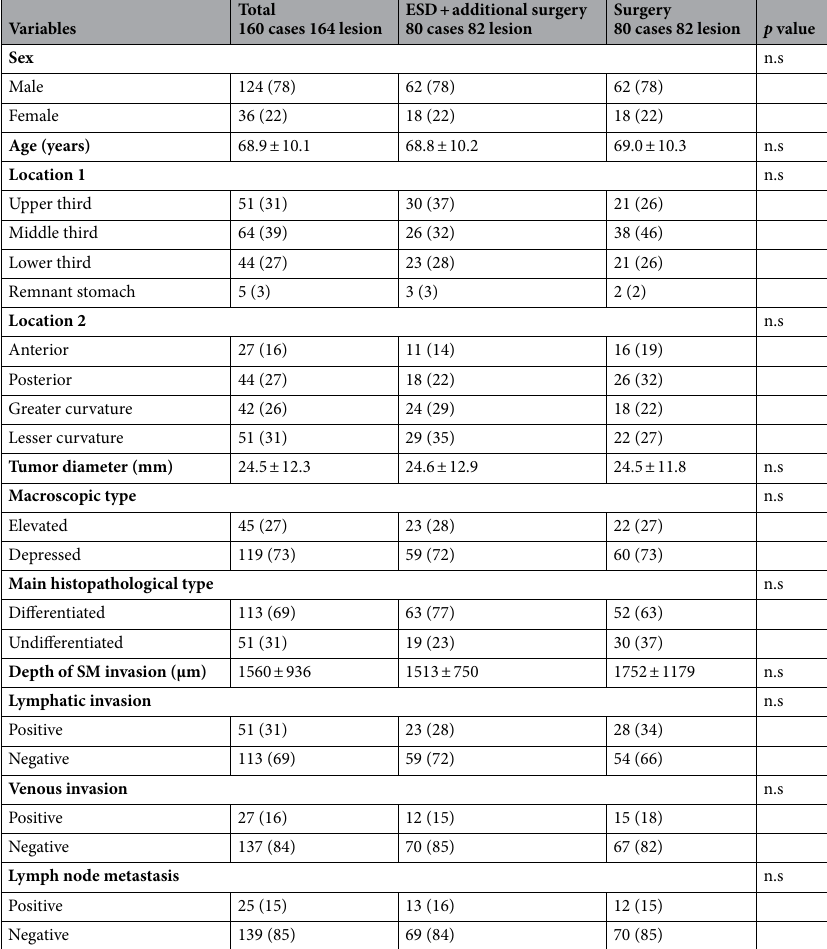
Table 3. Clinicopathological features of T1b2 gastric cancer after propensity